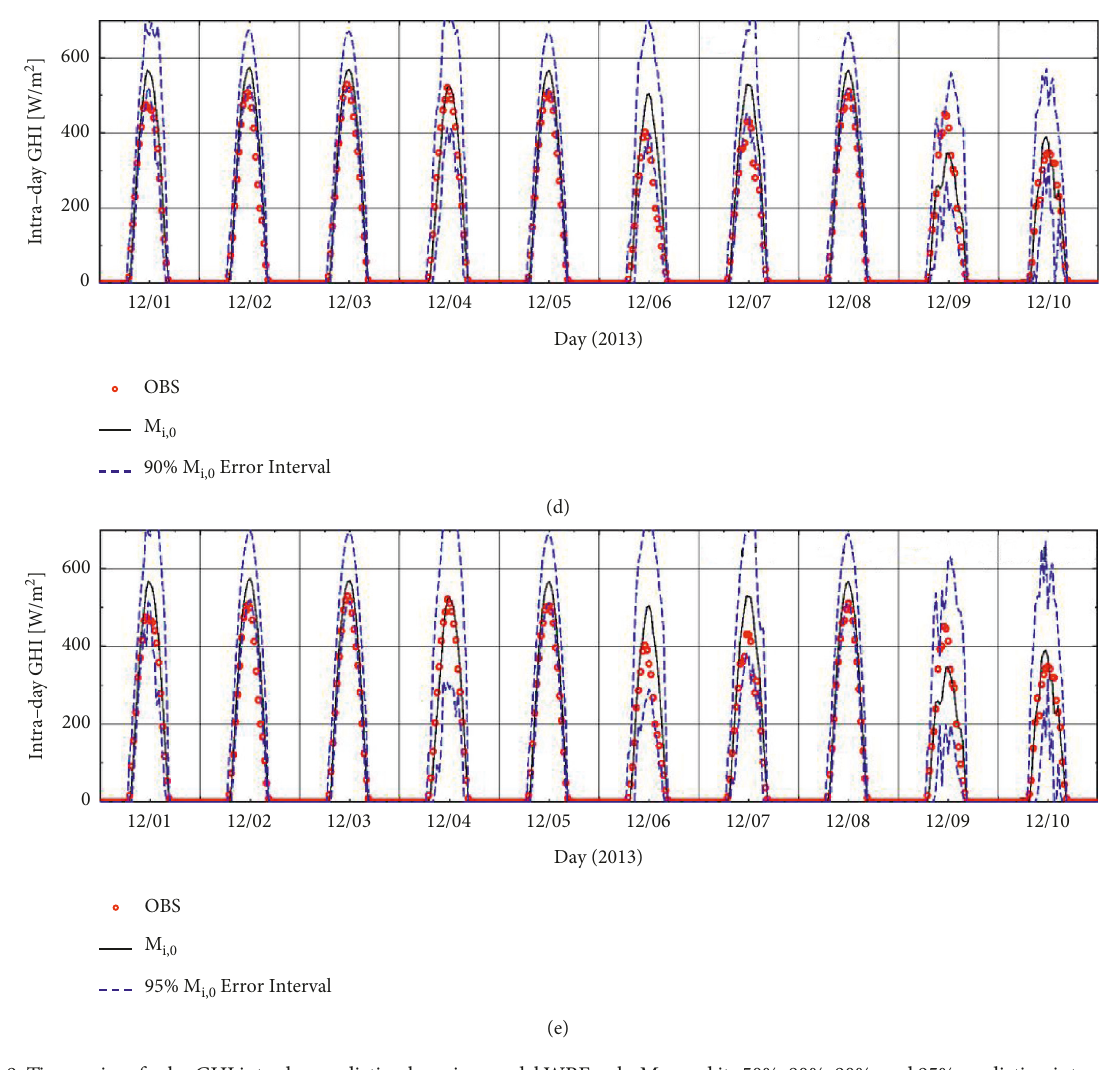
i, 0 and its 50%, 80%, 90%, and 95% prediction interval during prediction and ensemble spread, (b) M i, prediction and 50% prediction interval, (c) M i, 0 0 prediction and 90% prediction interval, and (e) M i, prediction and 95% prediction 0 0